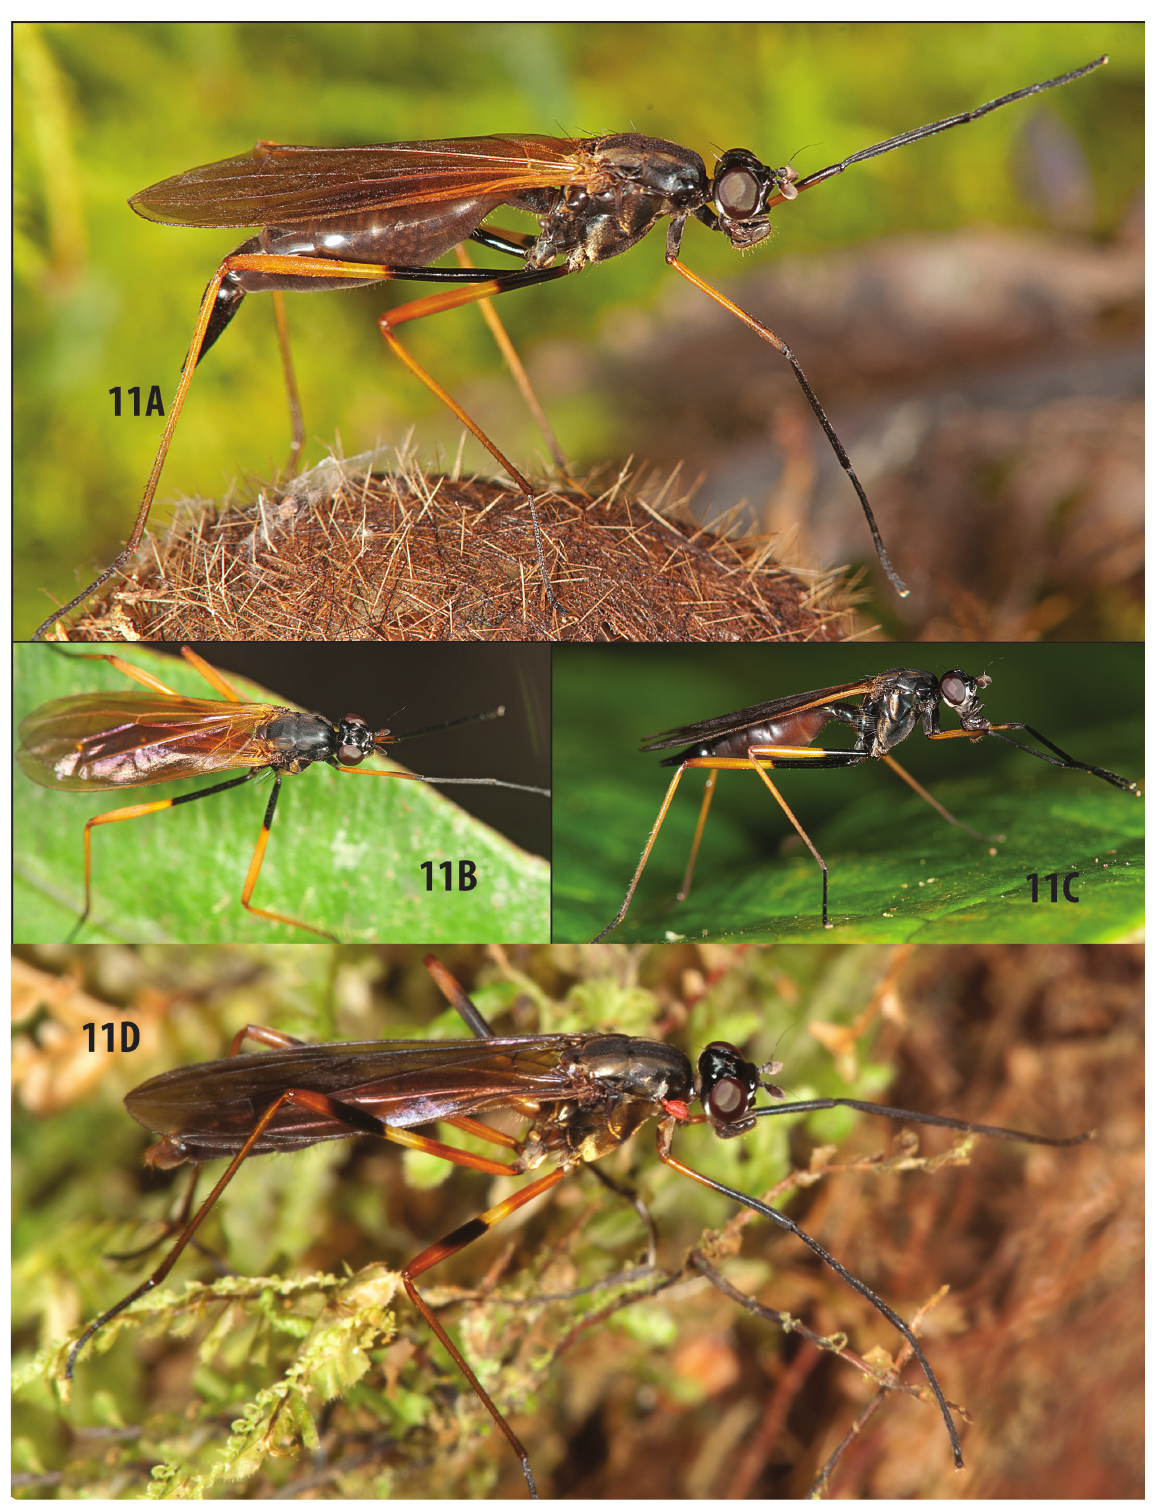
Fig. 11. Mesoconius nigripleuron sp. nov., living specimens, Peru . A–C . ♀♀. D .